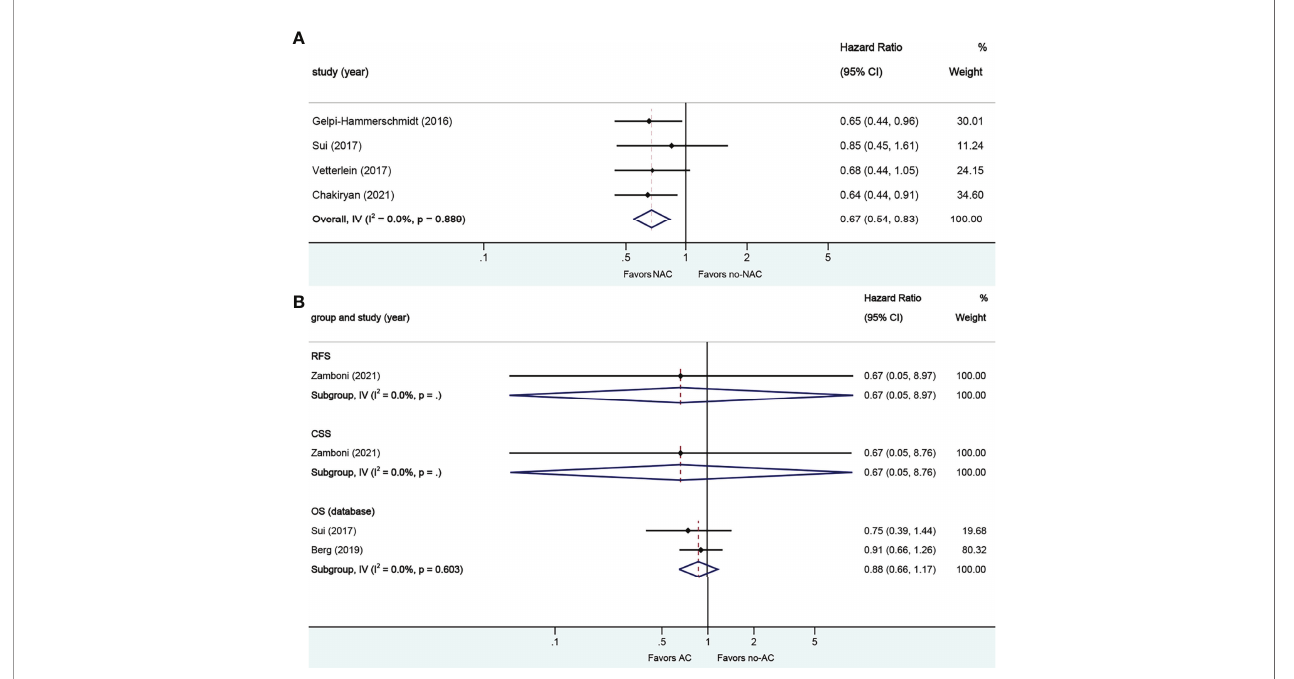
FIGURE 7 | Forest plots of studies investigating the association of chemotherapy with survival outcomes in sarcomatoid variant histology. (A) neoadjuvant chemotherapy; (B) adjuvant